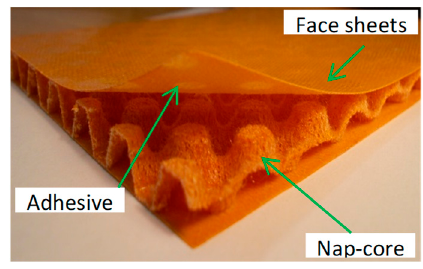
Figure 1. Layers and constituent parts of a symmetric nap-core sandwich.